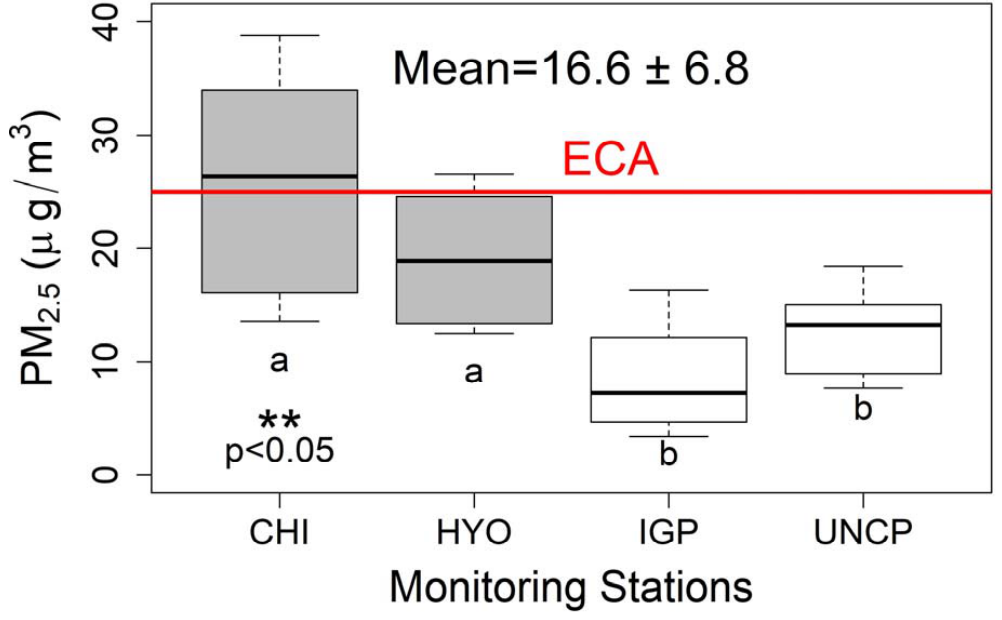
Figure. 2. Boxplot of mean mass concentration ± standard deviation (S.D.) of PM 2.5 at each monitoring station. Means with the same letter and color (a and b) code are not significantly different (Tukey multiple comparisons of means, p < 0.05). Red line = 25 μ g m − 3 value of National Air Quality Standards (ECA in Spanish) from Peru.